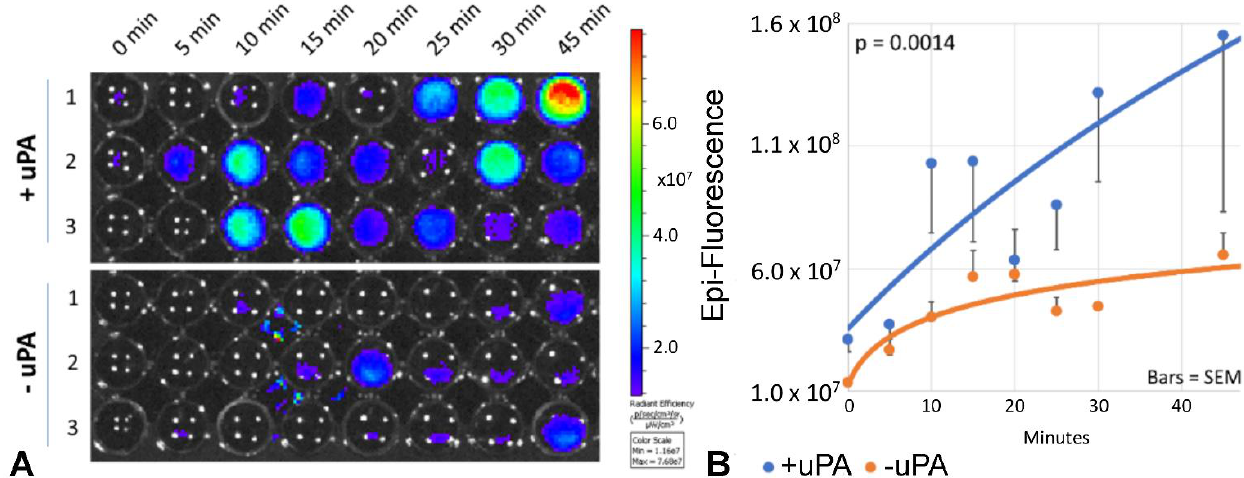
Figure 5. Urokinase can cleave the cmSA protein. ( A ) : IVIS™ images of media harvested from biotin (5-fluorescein) labeled cmSA-C17.2 incubated with or without uPA. ( B ) : Numerical data from panel A with best fit curves to demonstrate the trends. The repeated measures statistical test demonstrated the difference between uPA and no uPA was highly significant ( p = 0.0014).